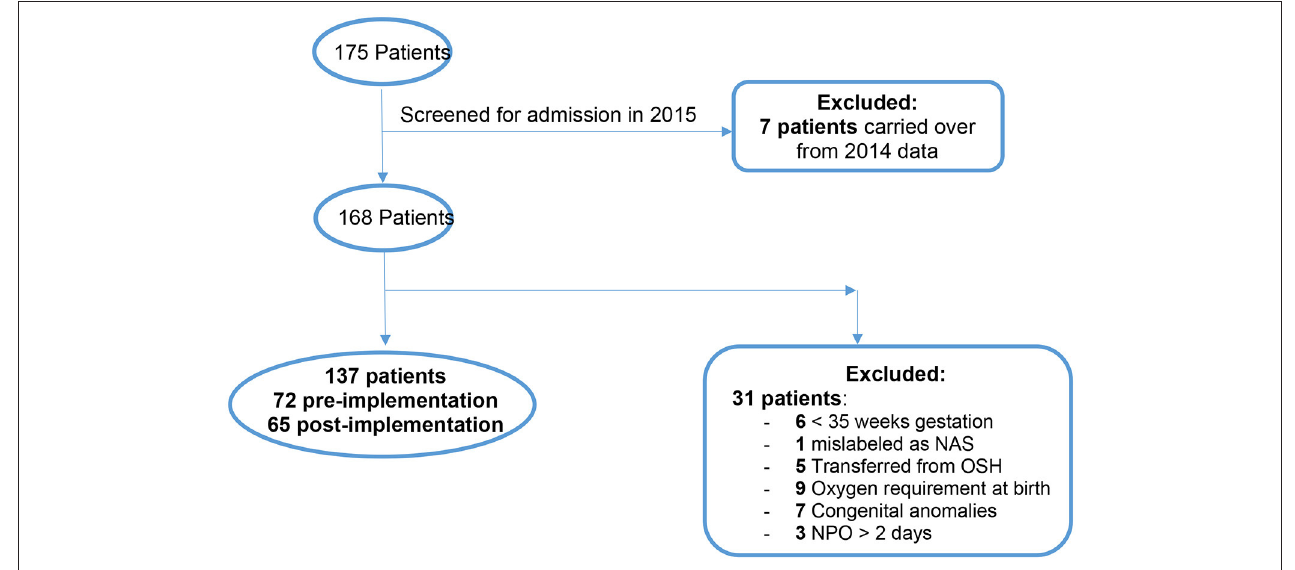
FIGURE 3 | Flow diagram of the study population.